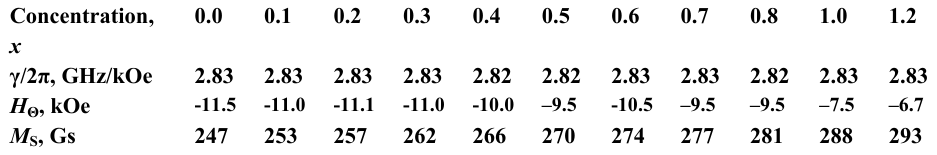
Table 2. Magnetomechanical ratios and MCA fields of the Ba 3 Co 2.5 – х Zn x Ti 0.5 Fe 23 O 41 (0.0 ≤ х ≤